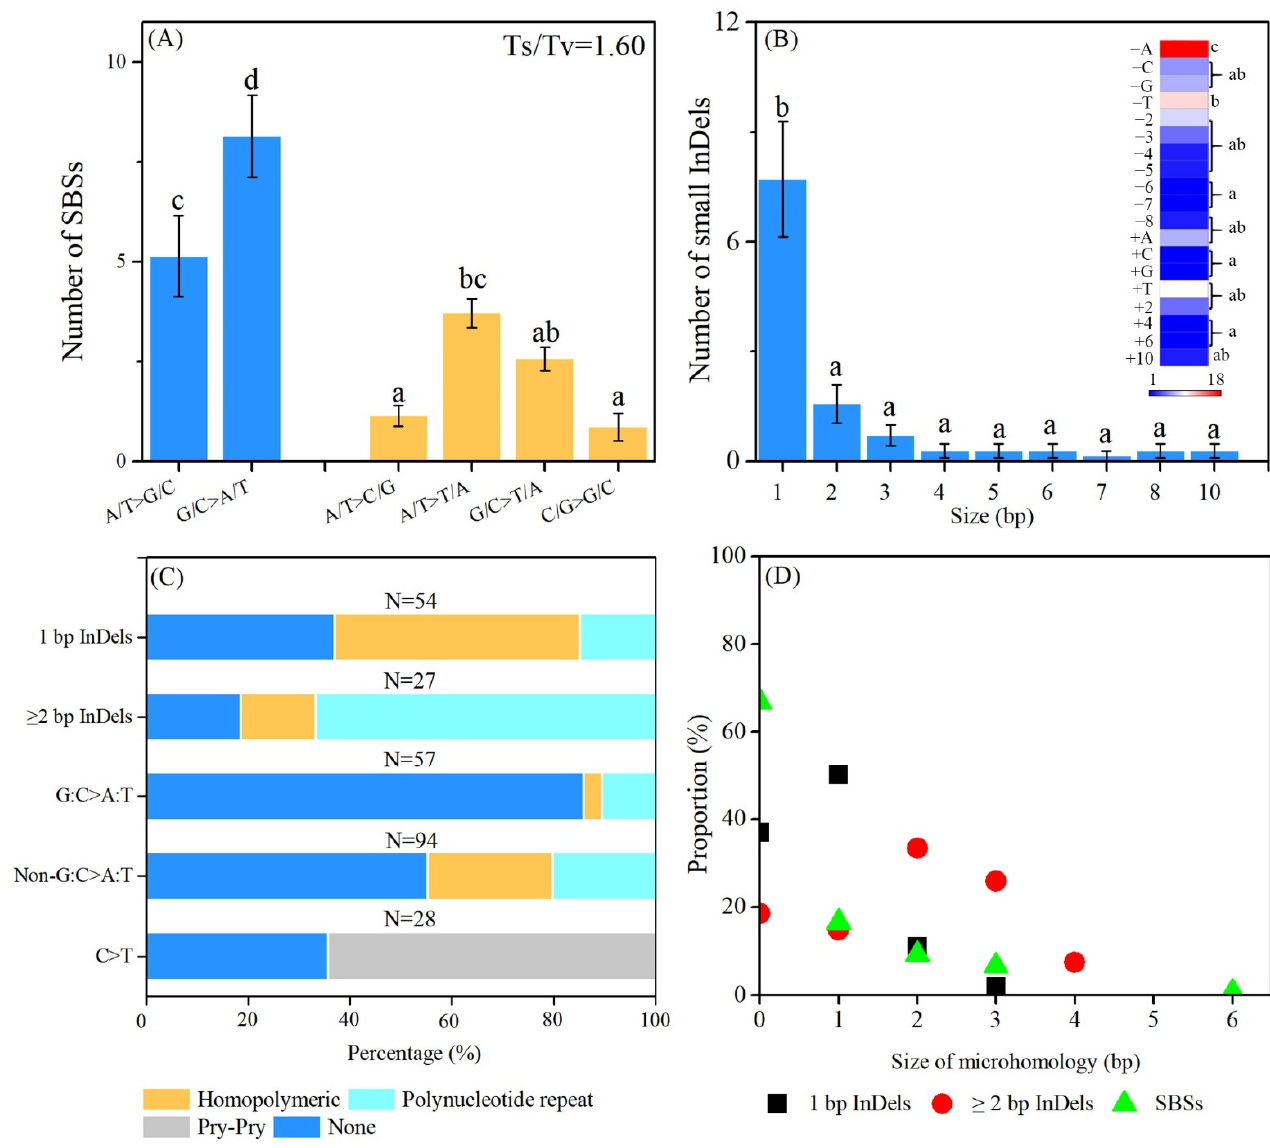
Figure 5. Characteristics of SBSs and small InDels induced by gamma rays. ( A ), Categories of SBSs. ( B ), size distribution of InDels. Each data point was mean ± standard error from seven replicates. Data followed by the same alphabetic letters are not significantly different between any two of the mutation types (( p > 0.05) by Duncan’s multiple range test. ( C ), Characteristics of preferential sequences flanking the DNA mutations. ( D ), Distribution of the size of microhomology observed at Indels and SBSs. Details of flanking sequences are shown in Supplementary Tables S2 and S3.